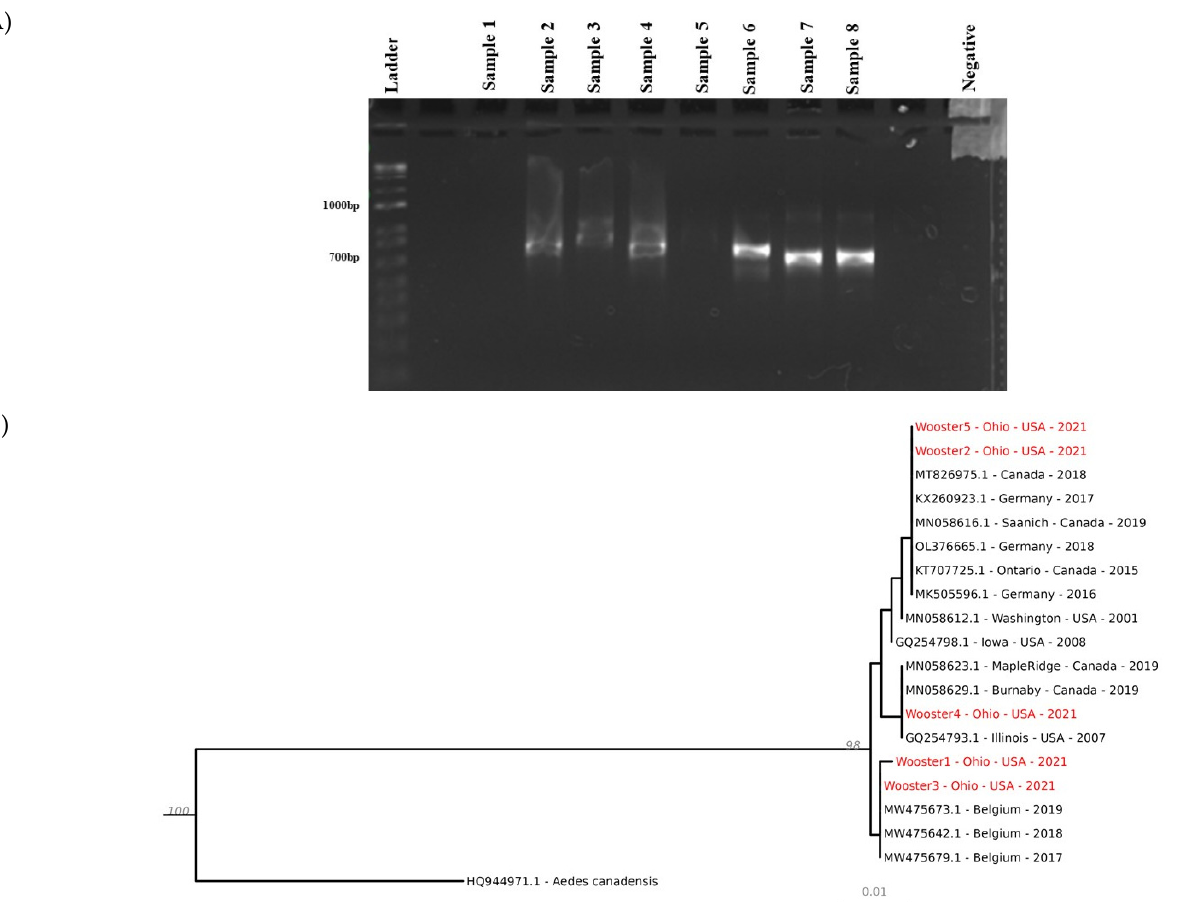
Figure 2. Molecular identification of Ae. japonicus . ( A ) Agarose gel electrophoresis. The first well was empty. Samples 1 to 8 represent individual mosquitoes. Nuclease-free water was used as a negative control. Eight samples were analyzed by PCR, and COI was successfully amplified from six mosquitoes. ( B ) Phylogenetic tree of Ae. japonicus using cytochrome oxidase subunit 1 from five samples that were successfully sequenced. Ae. canadensis was used as an outgroup.